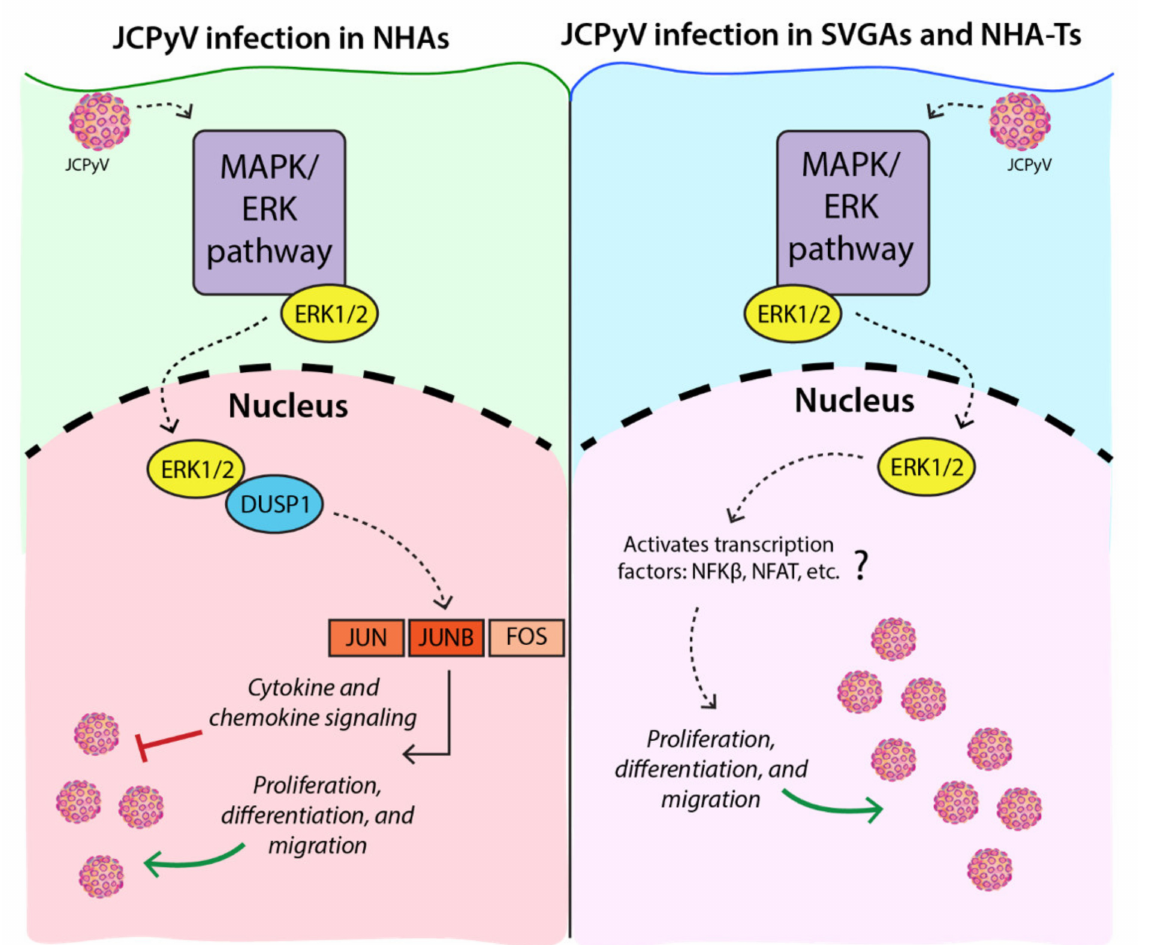
Figure 7. The MAPK/ERK pathway is required for JCPyV infection in primary and immortalized astrocytes but may activate additional pathways in primary astrocytes, specifically pathways involved in the immune response and facilitated by the transcription factor, JUNB , and other members to form the AP-1 complex. This may result in the inhibition and the delay of JCPyV infection observed in NHAs compared to immortalized astrocytes